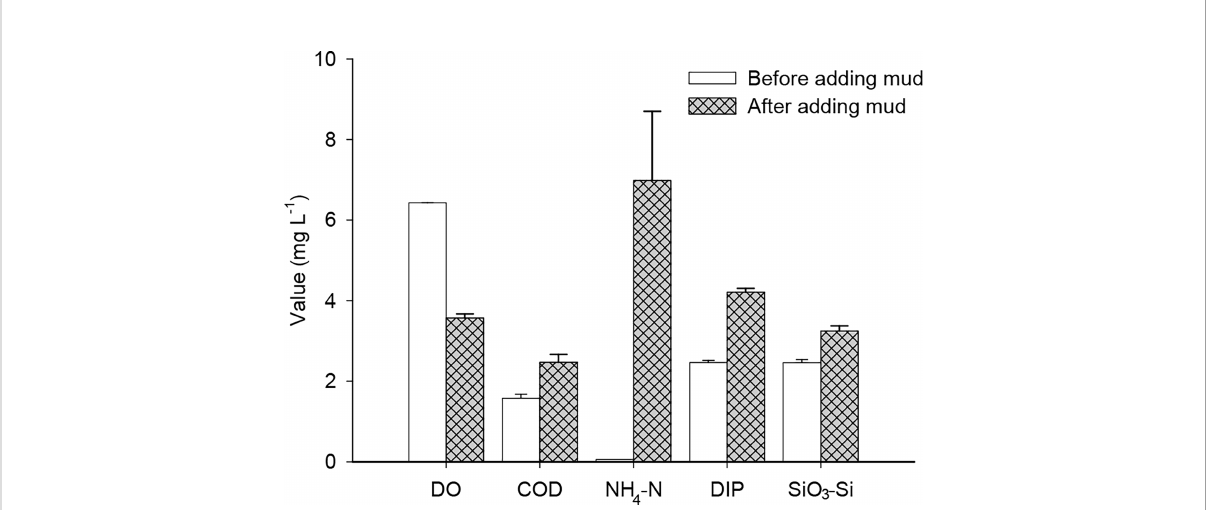
FIGURE 1 DO, COD, NH 4 -N, DIP, and SiO 3 -Si values before and after adding sediment into Mesocosm B (mean ± SD, NH 4 -N × 50, and DIP × 100).